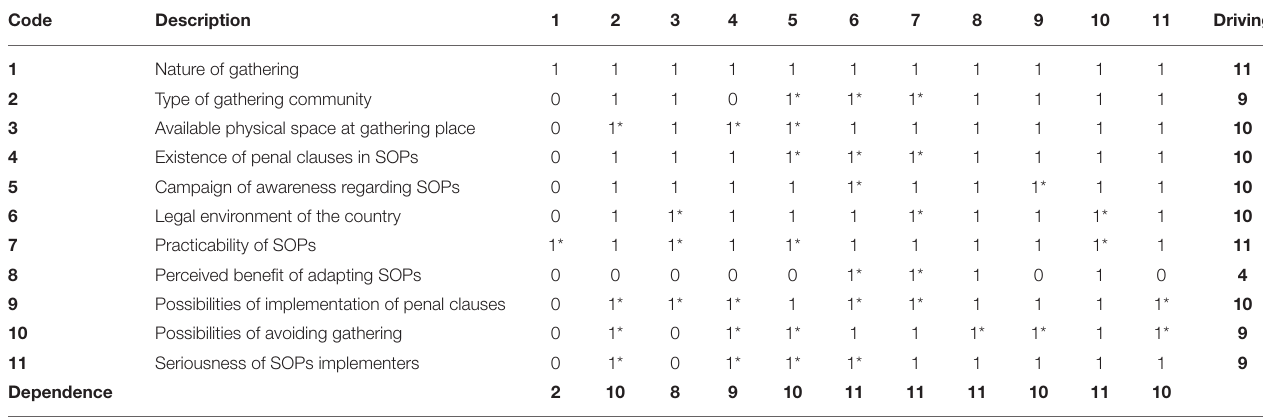
TABLE 5 | Final reachability